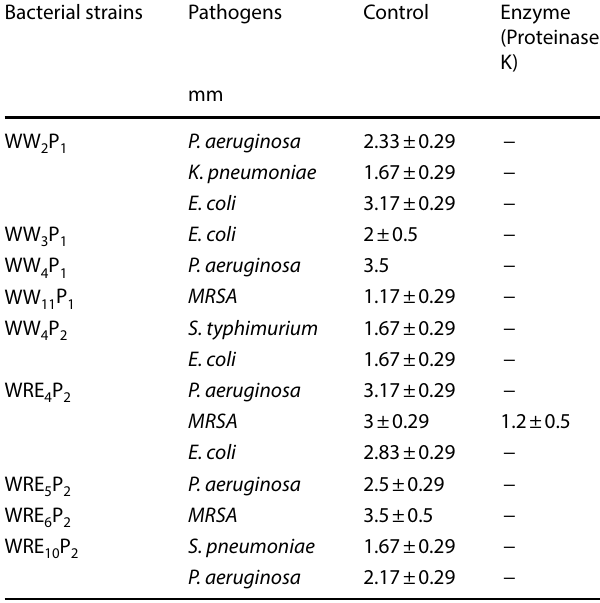
Table 3 Effect of proteinase K on bacteriocins activity